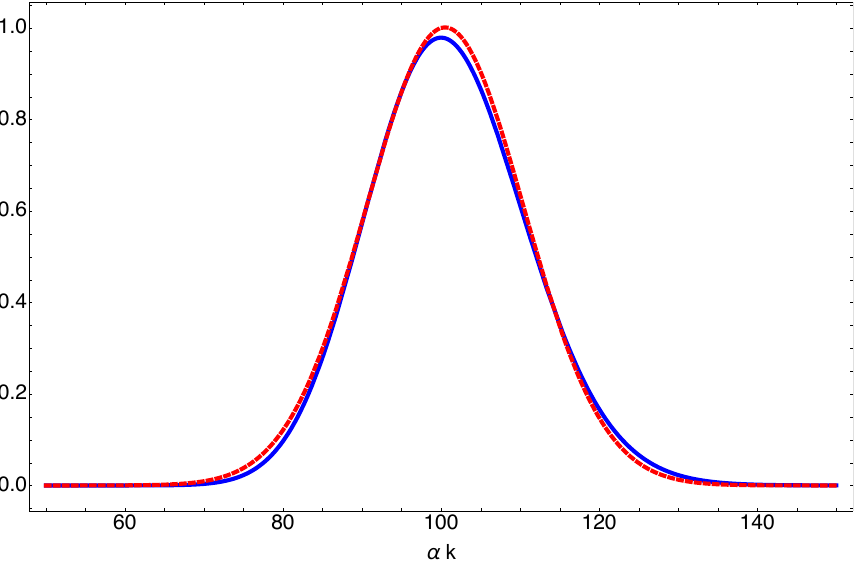
Figure 5. Comparison between exponentially decaying spectrum with large n (blue, solid line) and Gaussian spectrum (dashed, red line), for the case of n = 100. As can be seen, the spectrum of fundamental X-waves with a large n can be very well approximated with that of Bessel-X pulses. For this plot, k is measured in units of α , which means that k 0 = n = 100 and γ = 1/ n =